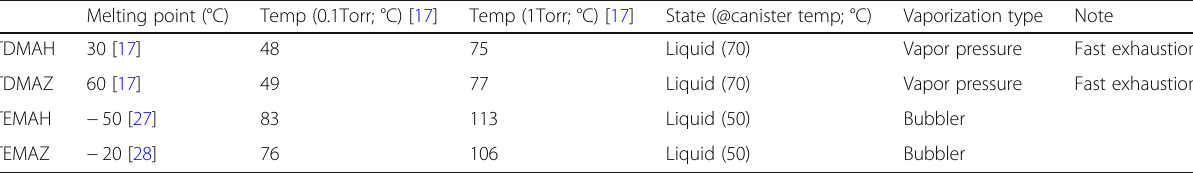
Table 1 Comparison between TDMA-Hf, Zr and TEMA-Hf, Zr source specification Melting point